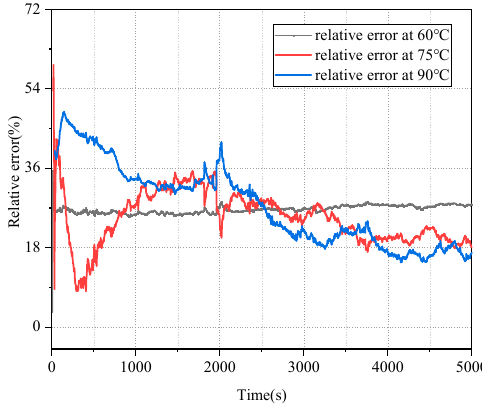
Figure 8. RE of the calculation curves and the measured curves based on the “master curve” technique.